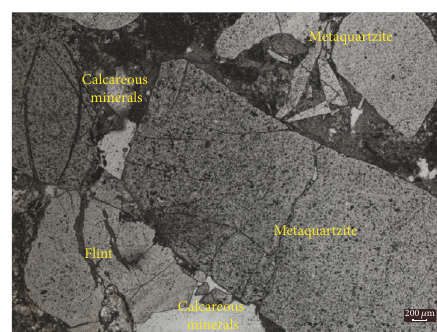
Figure 3: Analysis results of the polished